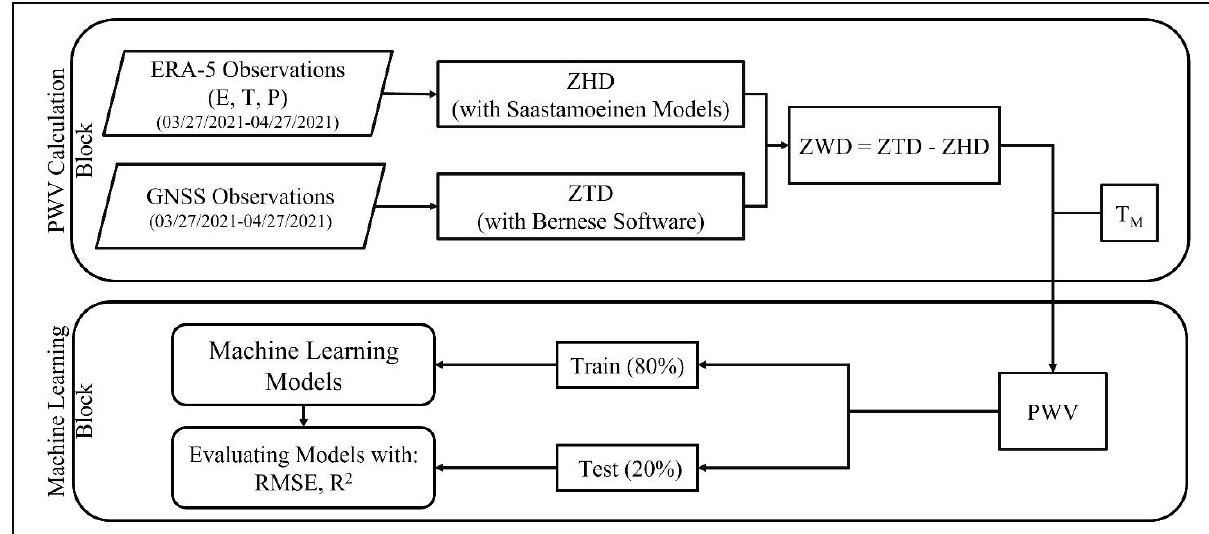
Figure 2. Diagram of different steps of training